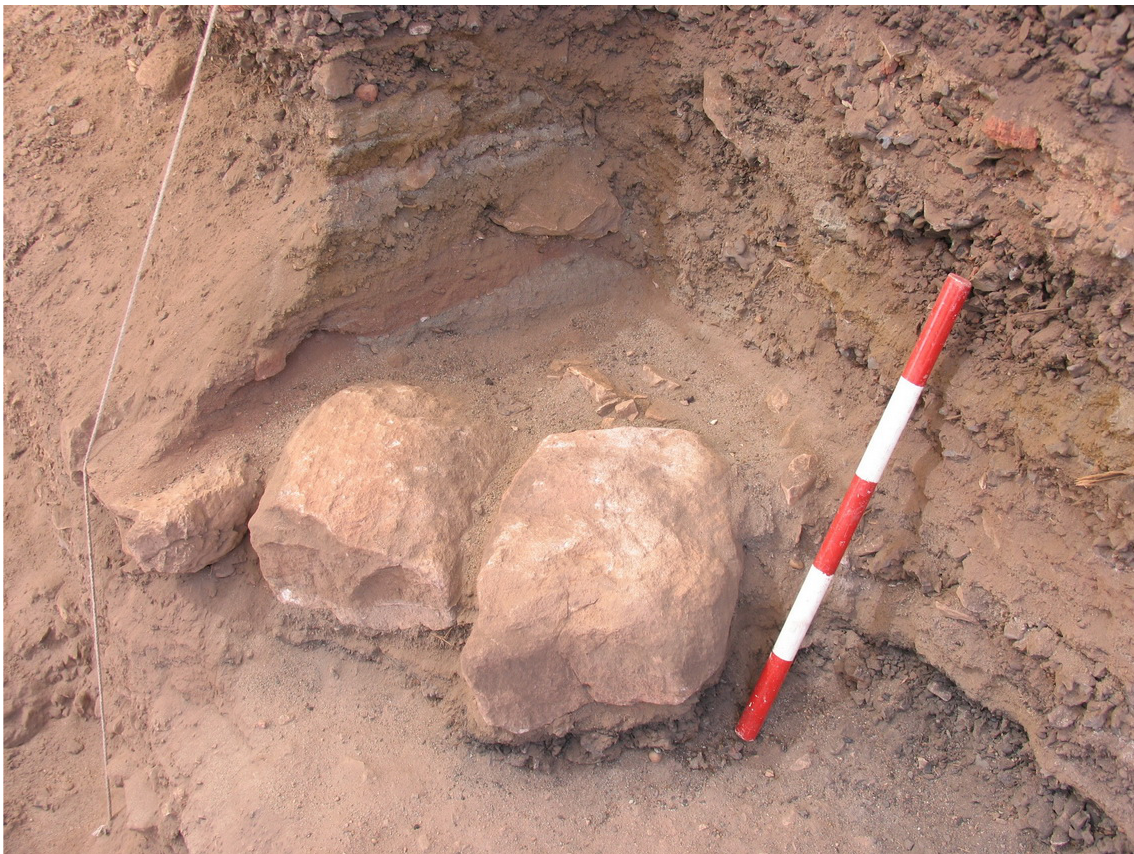
Figure 23. A rounded crushed-ore storage facility at Site 30 (Installation L.905). The green slag can be seen in the section (photo from Ben-Yosef et al . 2012: